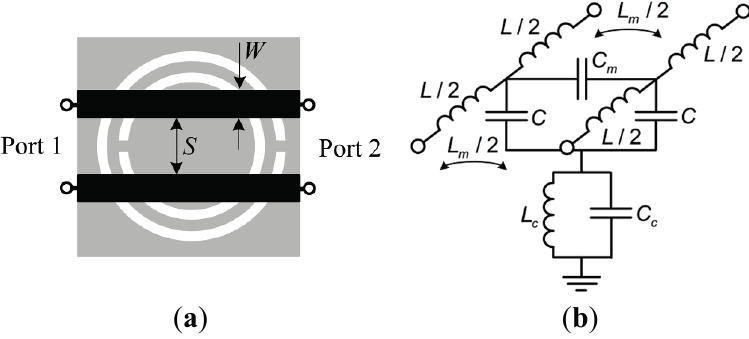
Figure 5. Topology ( a ) and circuit model ( b ) (elemental cell) of a differential microstrip line loaded with a CSRR.